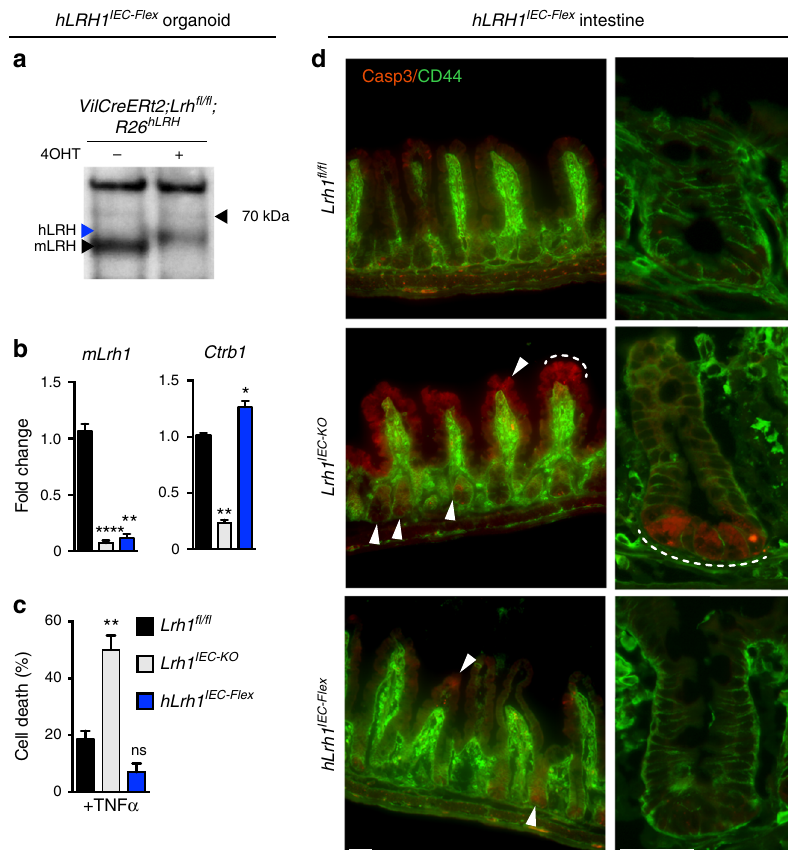
Fig. 4 In vivo rescue of Lrh1 IEC-KO mice by hLRH-1 reverses cell death. a LRH-1 protein levels in hLrh1 IEC-Flex enteroids detected by anti-LRH-1 antibody with arrowheads indicating migration of human (blue) or mouse (black) LRH-1 before or after addition of 4OHT, which eliminates mLRH-1 and promotes hLRH- 1 expression; protein extracts were isolated 72 h later. b Relative levels of mLRH-1 and a downstream LRH-1 target gene, Ctrb1 in wild-type ( Lrh1 fl / fl ), Lrh1 IEC- KO , and hLrh1 IEC-Flex enteroids, with values normalized to wild type set at 1.0. Generation of hLrh1 IEC-Flex is described in Methods. For all panels, data were generated from three independent wells of enteroids (~50 organoids per well) done in triplicate. c Percentage of cell death in hLrh1 IEC-Flex enteroids with TNF α (10 ng/ml, 40 h) after eliminating mLRH-1 (gray) and expressing hLRH-1 (blue) by addition of 4OHT for 48 h. Data are also shown for treated Lrh1 fl / fl enteroids (black). All values are normalized to fi ve independent wells of untreated Lrh1 fl / fl enteroids, which is taken to be 0%. d Immuno fl uorescence of wild-type ( Lrh1 fl / fl ), Lrh1 IEC-KO , and hLrh1 IEC-Flex ileum from adult male mice treated with two consecutive injections of tamoxifen. Staining for activated Casp3 (red) and CD44 (green), which marks intestinal epithelial crypt cells, is shown at lower ( fi rst column) and higher (second column) magni fi cation. The appearance of apoptotic cells is indicated in the crypt region as well as the villus (white arrowheads and dashed white line) in Lrh1 IEC-KO ileum; some signal is also observed after expressing hLRH-1 in hLrh1 IEC-Flex . Scale bars = 50 μ m. N = 2 per genotype. For panels b and c error bars are SEM with statistical analyses determined by Student ’ s unpaired t test, two tailed with p values of * p = < 0.05, ** p = < 0.01, and **** p = <